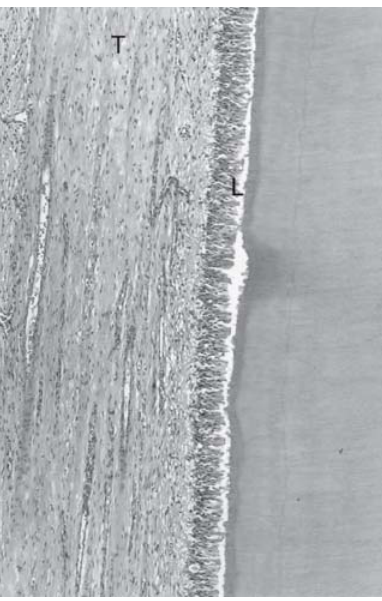
FIGURE 1- Group I (MTA): thick dentine bridge totally obliterating the pulp exposure (H). Normal connective pulp tissue (T). (hematoxylin and eosin - X 24)